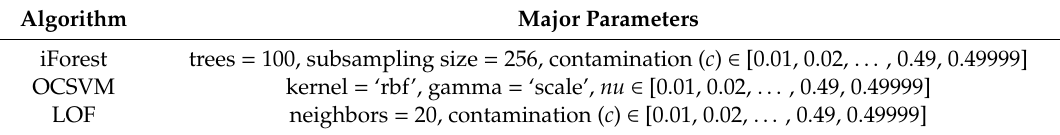
Table 5. Anomaly detection algorithms and their major